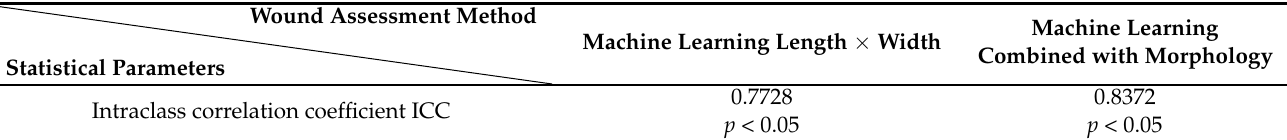
Table 5. The ICC results of the linear mixed model for repeated measurements between two types of AI algorithm in the presence of